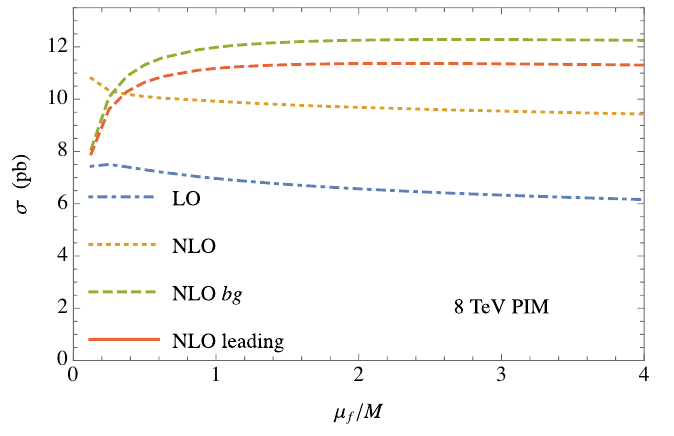
Figure 2 . The factorization scale dependence of the cross sections in the PIM scheme for tW (cid:0) production with p s = 8 TeV. The NLO result is obtained in the DS scheme. The plots are shown in the region 1 = 8 < (cid:22) f =M <